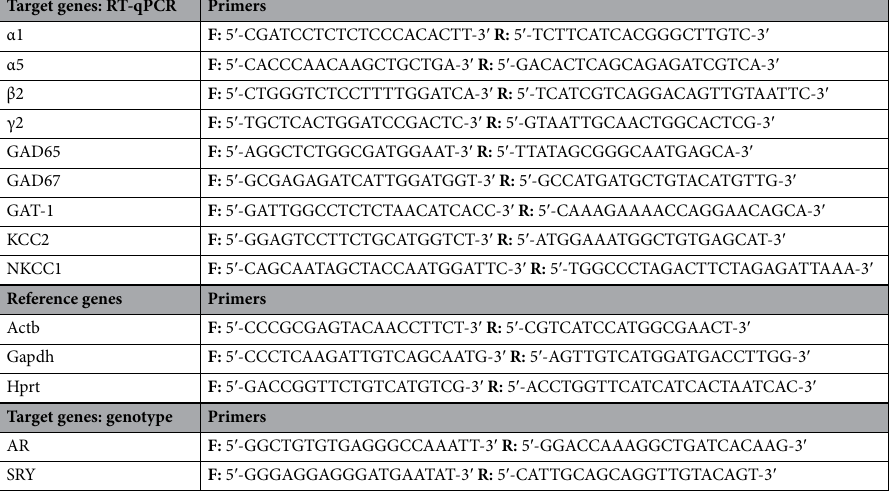
Sexual developmental markers. Sexual developmental markers were measured as described in Pallarés et al. 75 . AGD was measured using a vernier-caliper at P1. On P15, pups were re-examined for sexual phenotype, their sex confirmed or reassigned if necessary, and males and females were checked for areolas in a blind fashion. Areolas were deemed as either faint or normal, i.e. prominent and easily identified. On P35, female offspring were checked for vaginal opening (VO) and male offspring were monitored for testicular descent as indicators of puberty. Tfm males were dissected at P40 to confirm the presence of testis internally. Hormone assays. Trunk blood was collected at birth, centrifuged to separate the plasma, and analyzed for testosterone and estradiol levels. Testosterone and estradiol concentrations were measured using AlphaLISA kit (Perkin Elmer, cat: AL324, lot: 2477098) and ELISA kit (Abcam, cat: ab108667, lot: GR3214106-3), respectively, following the company’s protocol. RT‑qPCR. Total RNA was extracted using the “Aurum Total RNA fatty and fibrous tissue” kit and following the steps outlined in “Section 8: Spin protocol” of the instruction manual (732-6830, Bio-rad). The quality of extracted total RNA was assessed using a Bioanalyzer (CHUSJ, Montreal, QC, Canada) and conformed with high purity and integrity standards to perform RT-qPCR. The reverse transcription of RNA into cDNA and the following qPCR were performed in collaboration with IRIC (Institute for Research in Immunology and Cancer, Montreal, QC, Canada). Three endogenous controls (ACTB, HPRT, GAPDH) were tested and GAPDH being the more stably expressed across samples was chosen for the final analysis as the reference gene. Details of RT- qPCR primer sequences are listed in Table 1. Western blot. Whole lysate proteins and membrane protein fractions were extracted from hippocampal tissue at P7 and P40 following previously described protocols 58,76 . In particular, to obtain membrane protein fractions, samples were homogenized in 5 vol of HB (300 mM sucrose/10 mM Tris–HCl, pH 7.5/1 mM EDTA/ protease inhibitor mixture) and centrifuged at 1000× g for 10 min at 4 °C. The pellet was washed in 0.5 vol HB and used as the nuclear fraction. Supernatants were centrifuged at 17,000× g for 15 min at 4 °C, yielding the mito- chondria fraction. The supernatant was further separated by ultracentrifugation at 100,000× g for 1 h. The pellet and supernatant were used as the membrane and cytosol fractions, respectively. Membranes were probed with the following primary antibodies: anti-KCC2 1:1000 (rabbit polyclonal IgG; Cat. no. 07-432, Millipore), 1:200 anti-BDNF (BDNF, mouse monoclonal IgG, Cat. no. 327100, Icosagen), anti-glyceraldehyde-3-phosphate dehy- drogenase 1:4000 (GAPDH, mouse monoclonal IgG; Cat. no. AM4300; Applied Biosystems) and anti-β dystro- glycan 1:3000 (rabbit polyclonal IgG, Cat no. ab43125, Abcam). All samples were run simultaneously. Bands were quantified using ImageJ v.1.52 software (National Institutes of Health, USA, http:// imagej. nih. gov/ ij). The intensity of KCC2 and BDNF bands were normalized over the intensity of the GAPDH band for whole lysates or of the β dystroglycan band for membrane fractions, in the same lane (internal loading control). We did not quantify KCC2 dimer band because it was not detectable in all samples. Full gels of western blot with molecular weight markers are shown in Supplementary Figs. S1 and S2. During all experimental steps, the experimenter was blinded to the treatment groups. Hippocampal slice preparation and in vitro electrophysiology. Brain slices were prepared as previ- ously described by Sanon et al. 77 . Briefly, WT rats aged 38–42 days old were anaesthetized with isoflurane (Baxter corp, Mississauga, ON, Canada) and rapidly decapitated. The brain was extracted and immersed in cold (4 °C) and oxygenated (95% O